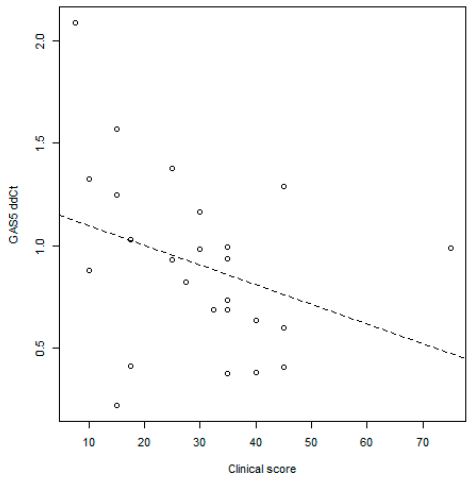
Figure 2. Correlation between GAS5 levels evaluated in inflamed tissue and the clinical score; Spearman test p = 0.048; r = − 0.40.